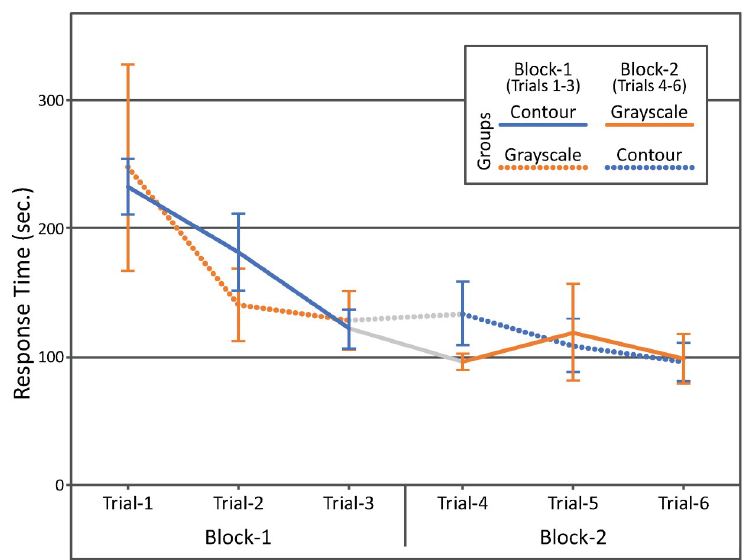
Fig 5. The results obtained in Experiment 1. The ordinate shows the response time and the abscissa shows the trials. The colors of the plots represent the image filters and the styles of the plots represent the groups of participants. The error bars show the standard errors across the participants. The 95 percent confidence intervals based on the t - − 1 ( p = 0.975, n = 6) = 2.45). distribution are 2.45 times of the standard errors ( CDF t